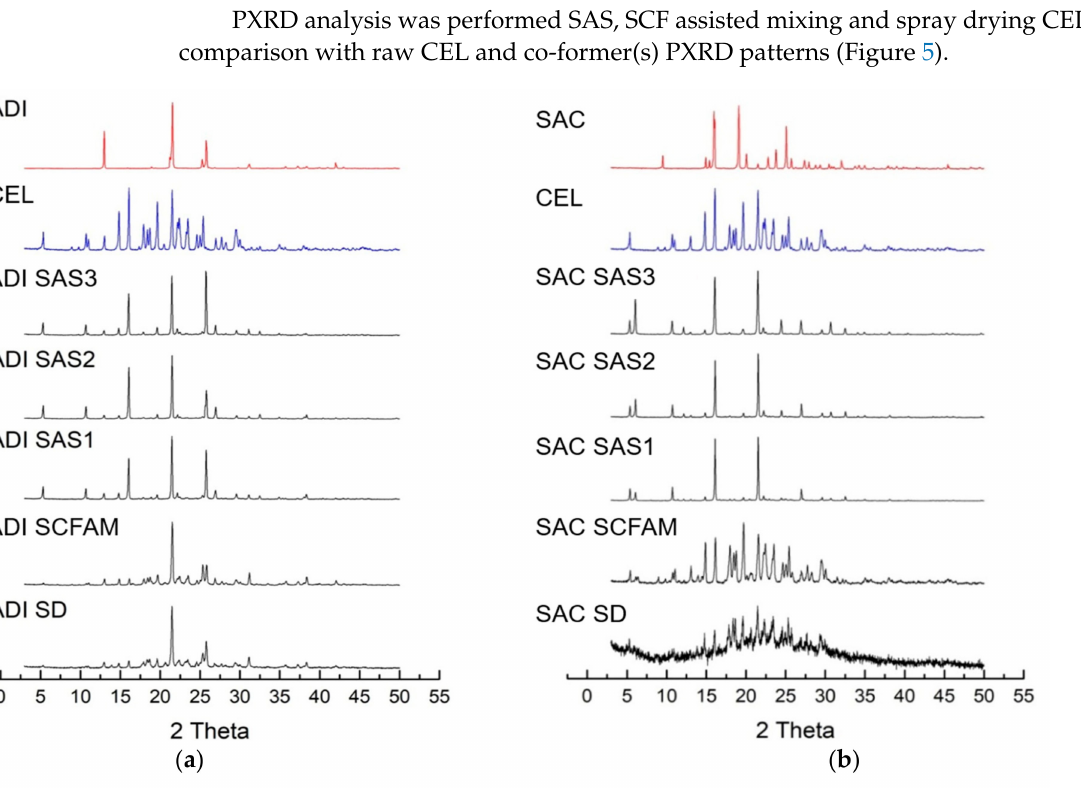
Figure 5. PXRD results of CEL EM: ( a ) CEL-ADI EM; ( b ) CEL-SAC EM. SAS 3 (temperature: 45 ◦ C), SAS 2 (temperature: 40 ◦ C), SAS 1 (temperature: 35 ◦ C), SCFAM: SCF assisted mixing, SD: spray